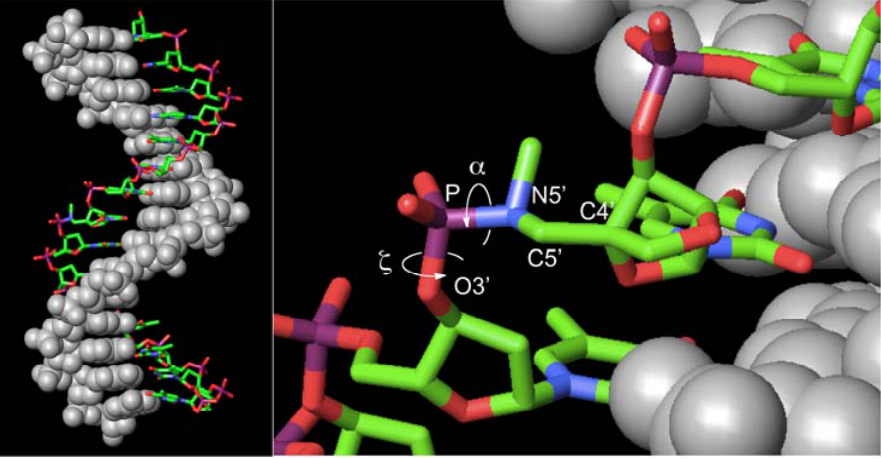
Figure 5. Molecular model of the ON-1 • ASD duplex. ON-1 and ASD rendered as stick (colored by element) and space-filling (gray) models, respectively. α (O3’-P-N5’-C5’) and ζ